Question: Author a descriptive caption for the visualization shown.
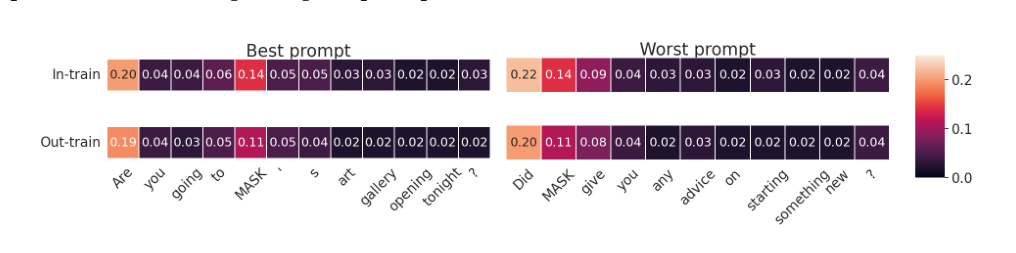
Answer: Attention heatmaps of the best and the worst prompts of BERT-B on the dev set averaged over all attention heads and layers. The attention weights corresponding to each prompt’s “MASK” token are used and averaged over the In-train and Out-train PERs separately.